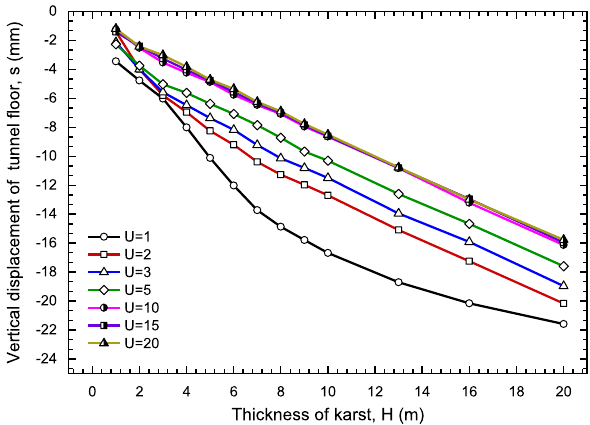
Figure 13. The effect of giant karst depth on tunnel floor settlement.